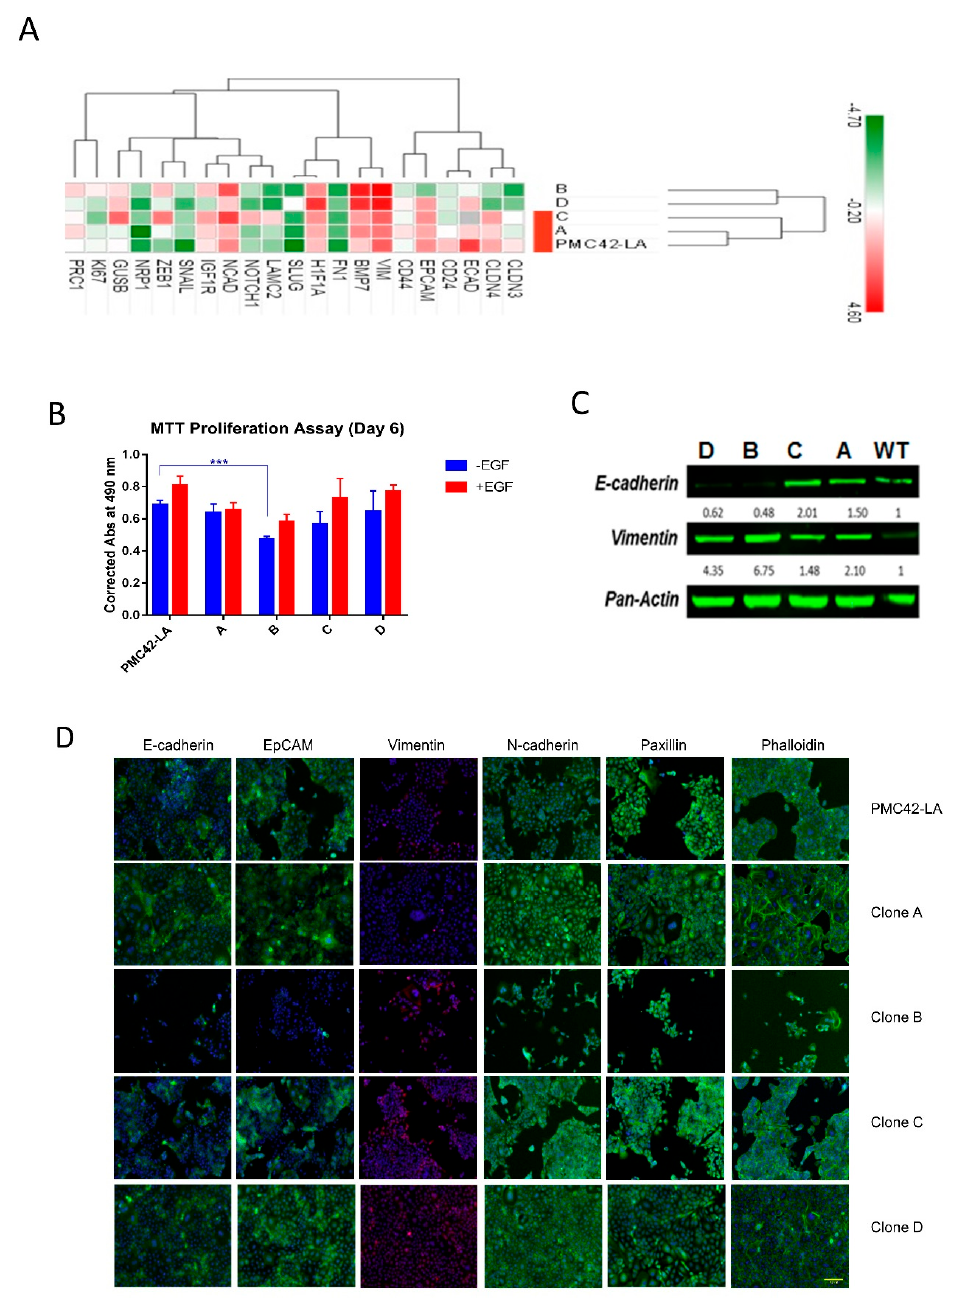
Figure 6. ( A ) Hierarchical clustering of the ∆ Ct values for the transcriptome data with epithelial-mesenchymal transition (EMT) marker genes for the four clones and PMC42-LA cell line. ( B ) Proliferation rate assessment for the selected clones and parental PMC42-LA with and without epidermal growth factor (EGF) stimulation ( n = 3). Significant di ff erences were calculated by two-way ANOVA and Sidak’s multiple comparisons test. *** P < 0.001 ( C ) The expression of E-cadherin and vimentin as determined by immunoblotting for the clones and parental PMC42-LA cells. Pan Actin was used as the loading control. ( D ) Immunofluorescence microscopy analysis of changes in the localization and expression levels of EMT influencing marker proteins. Selected clones and parental PMC42-LA subline were stained with antibodies against the epithelial markers E-cadherin and EpCAM, against the mesenchymal marker Vimentin and N-cadherin, against paxillin to detect focal adhesion plaques, and with phalloidin to visualize the actin cytoskeleton. Scale bar, 100 µ